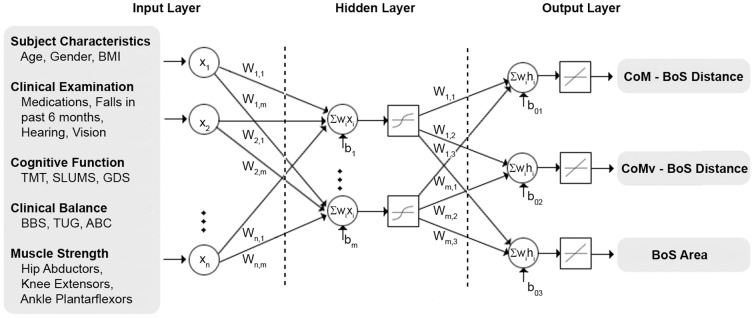
Neural network architecture representing the three layers as well as the tangential sigmoid and pure linear transfer functions in the hidden and output layers, respectively.All nodes are not represented in this diagram, though a weighted sum of all inputs and the bias is performed at each node in the hidden and output layers.